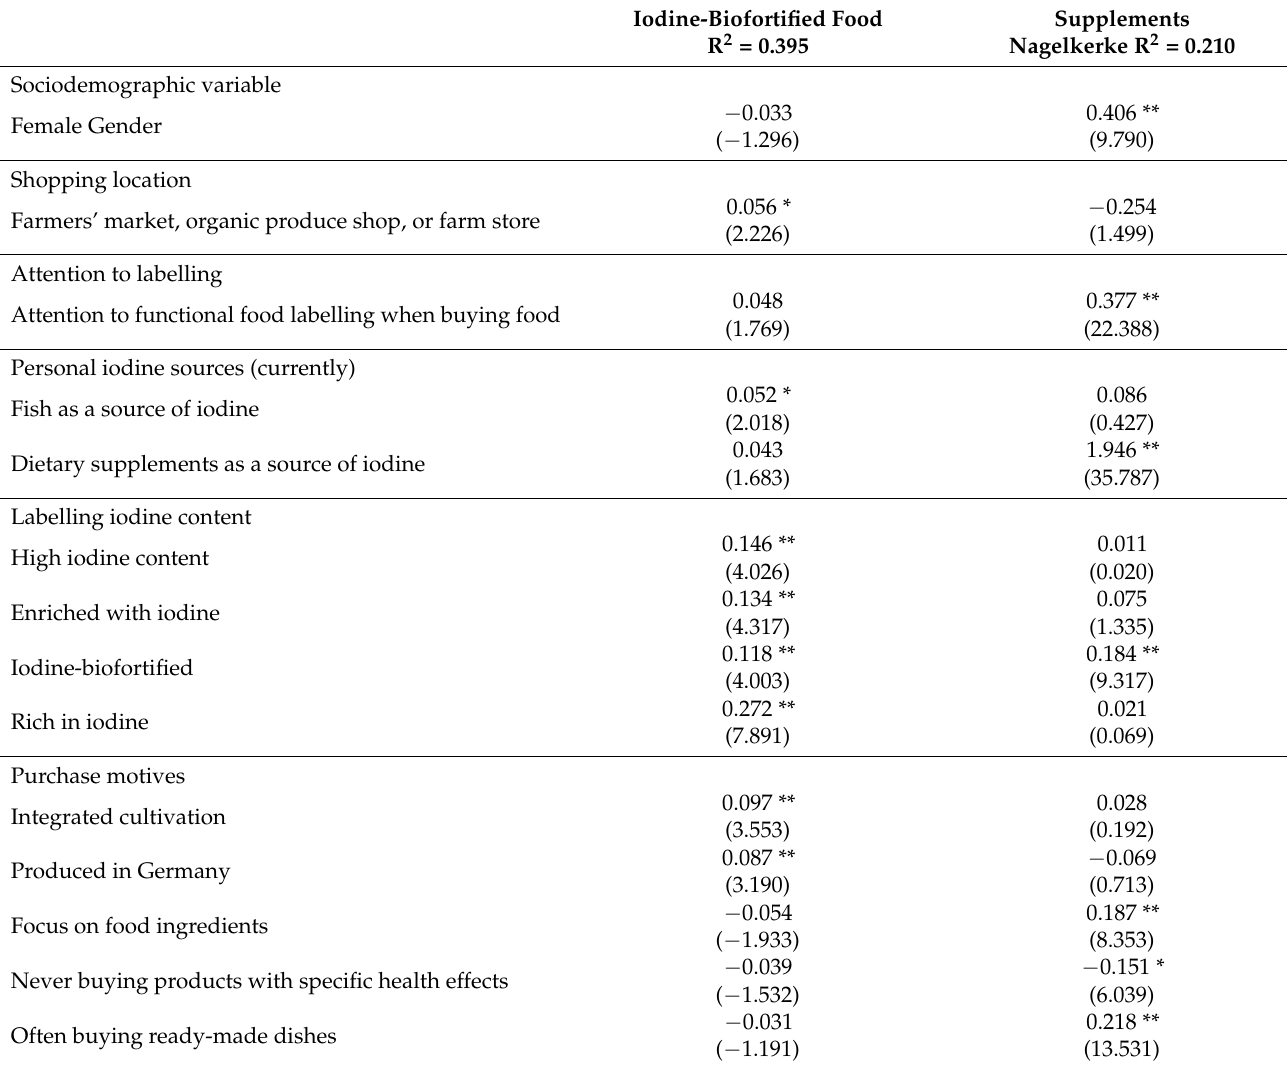
Table 3. Results of the regression analysis of concept acceptance. n =